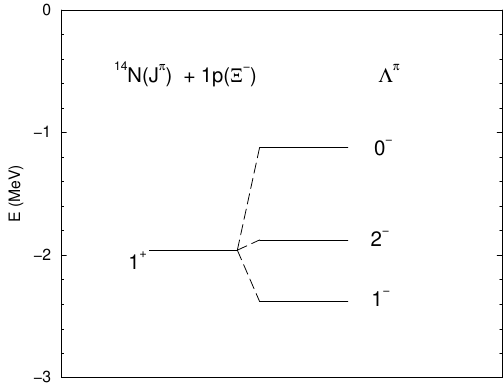
Figure 1. Energies (in MeV) of Λ π = (0 − , 1 − , 2 − ) triplet of 14 N g . s . + 1 p Ξ − states, split by a Q N · Q Ξ residual interaction (3). The (2 Λ + 1)-averaged energy − 1 . 96 MeV was calculated using the same Pauli-corrected optical potential parameter b 0 that yields a 12 C g . s . + 1 p Ξ − state at − 0.82 MeV, corresponding to the Ξ − capture events in 12 C listed in Table 1. Figure updating Fig. 2 in Ref.